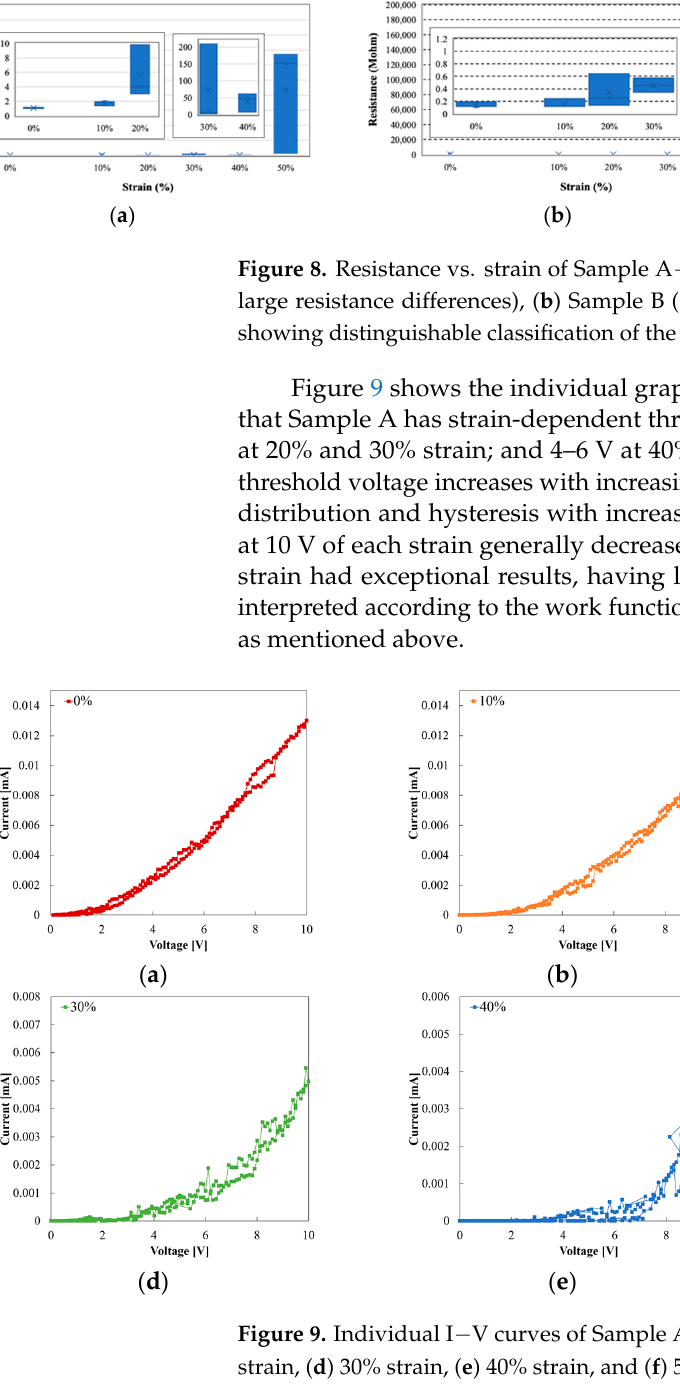
Figure 8. Resistance vs. strain of Sample A − C: ( a ) Sample A (Insets show magnified view due to large resistance differences), ( b ) Sample B (the inset shows a magnified view), and ( c ) Sample C showing distinguishable classification of the strain.